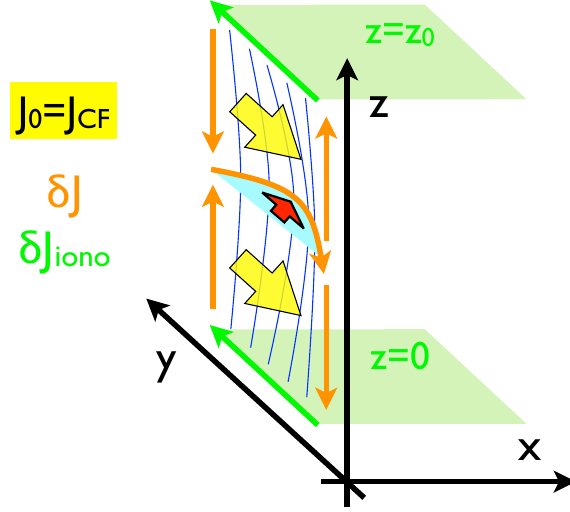
Fig. 7. Current system in the fundamental KS-mode. The indenta- tion of the equatorial magnetopause (red arrow) is associated with a disturbance surface current (orange arrows), which increases the CF current (yellow arrows). The localization of the indentation makes the currents to be closed via field aligned currents to the ionosphere, where they are closed via ionospheric currents (green